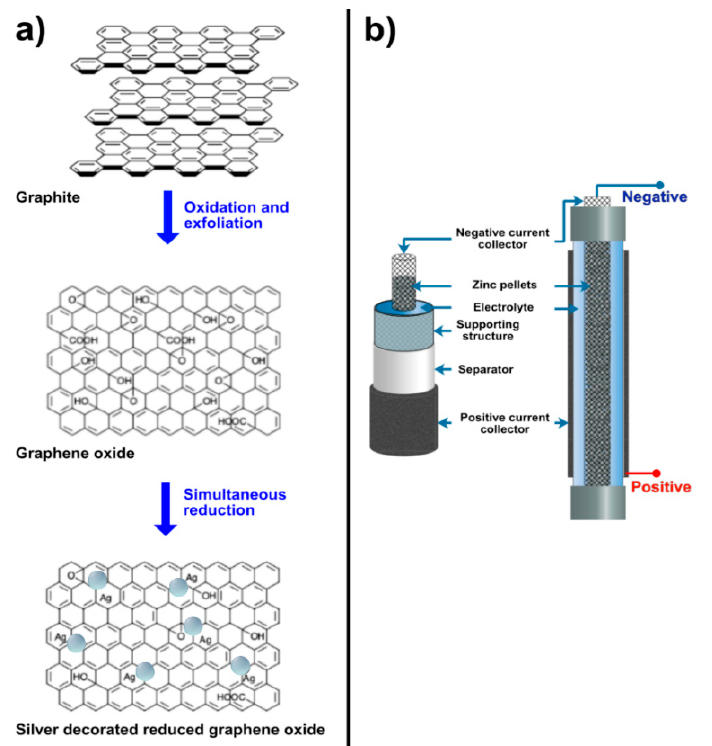
Figure 1. ( a ) Formation of silver nanoparticles decorated on reduced graphene oxide sheets by oxidation and exfoliation of graphite powder and simultaneous reduction of graphene oxide and silver ions, ( b ) a schematic diagram of the zinc–air battery.